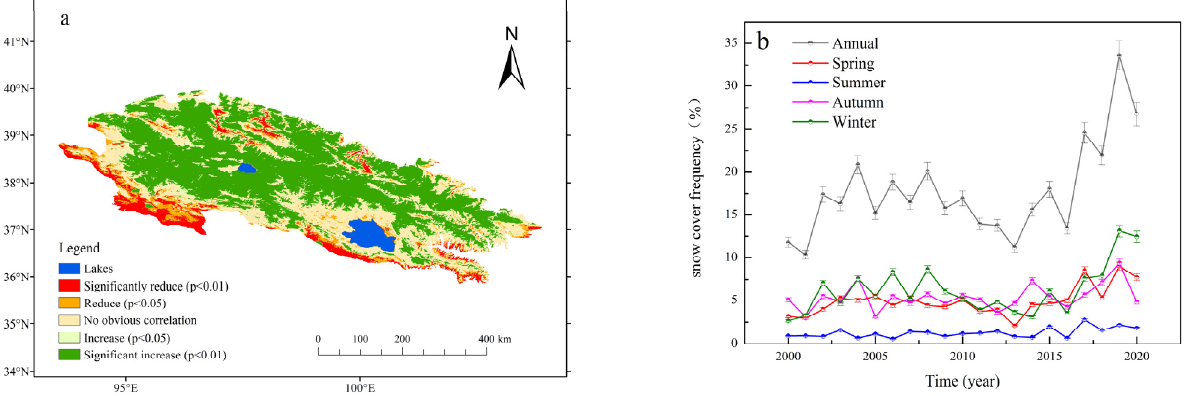
Figure 3. Temporal variation of annual SCF during 2000–2020: ( a ) temporal variation of spatial pattern and ( b ) variation of annual SCF.